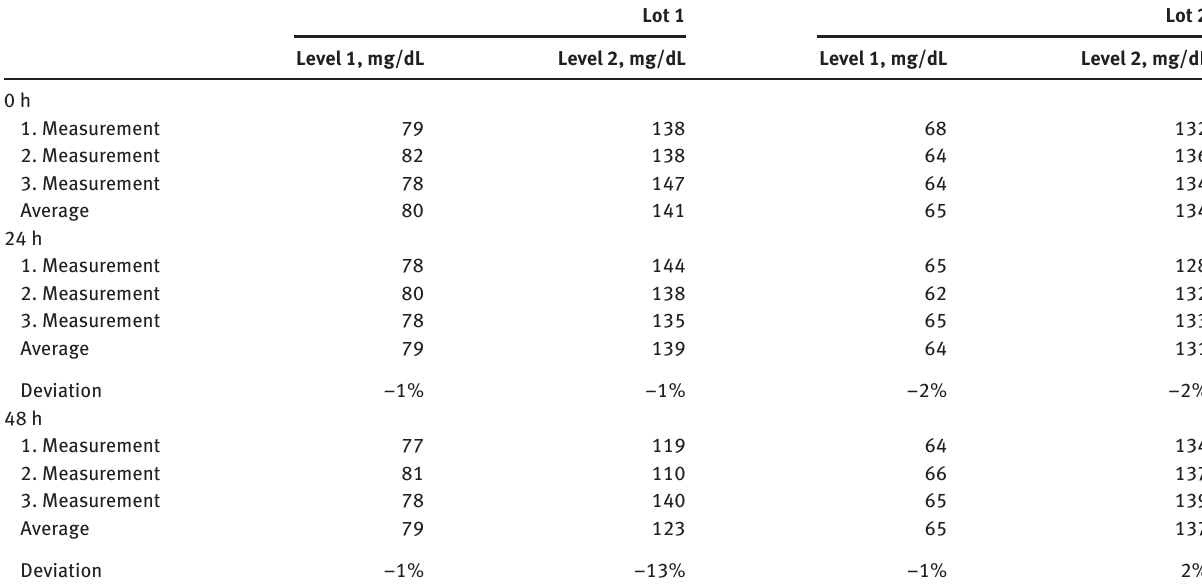
Table 3: Stability of blood glucose concentration in capillaries with sodium fluoride stored at 4 °